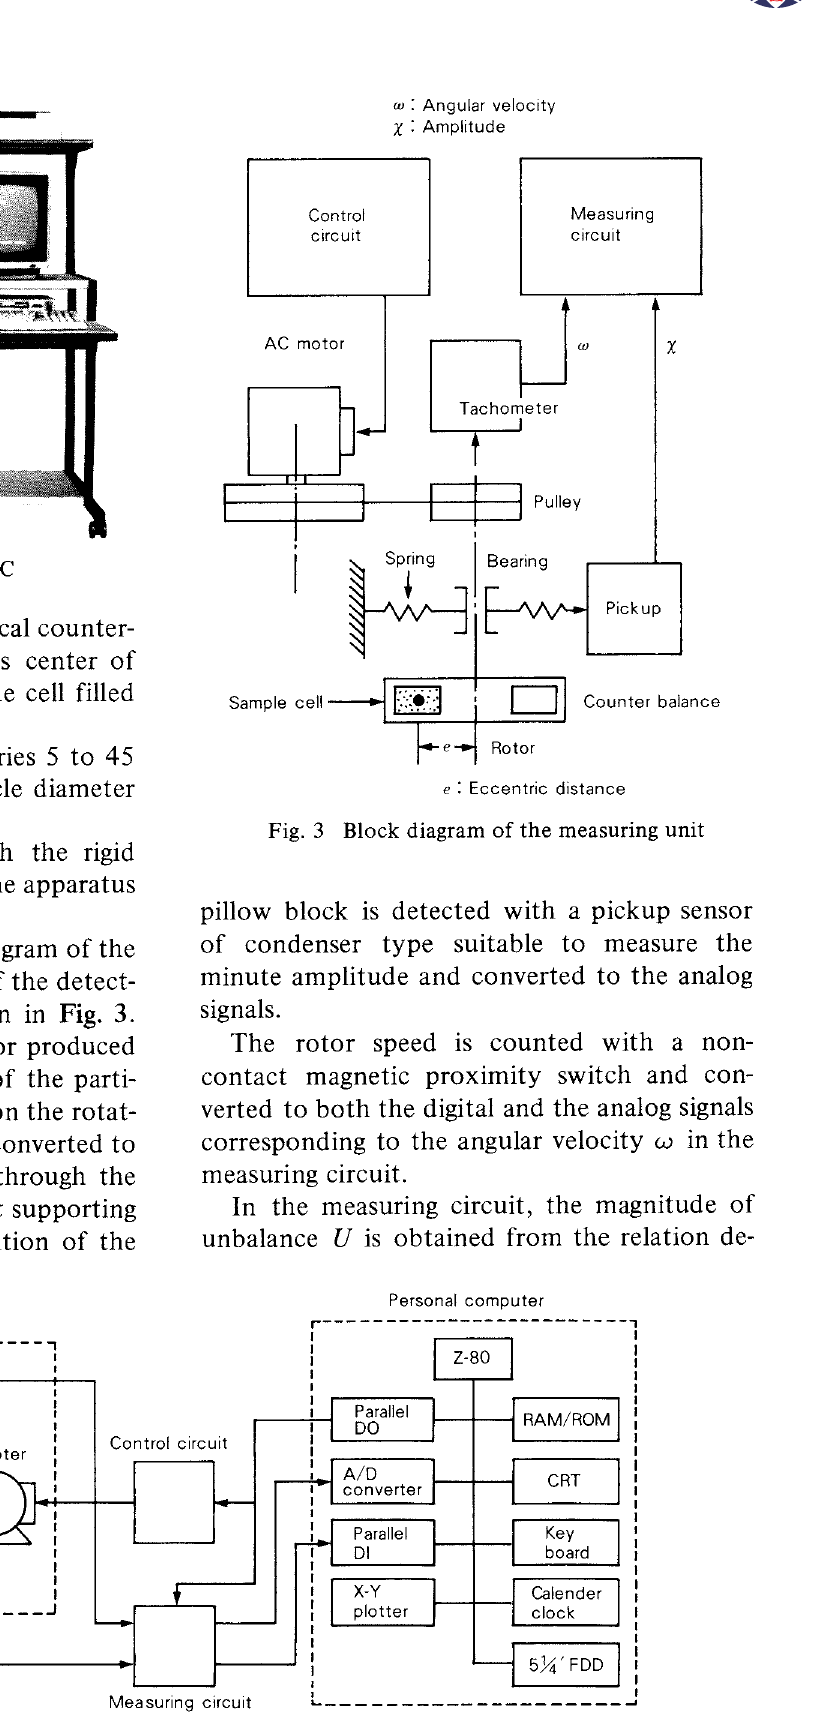
Fig. 2 Measurement